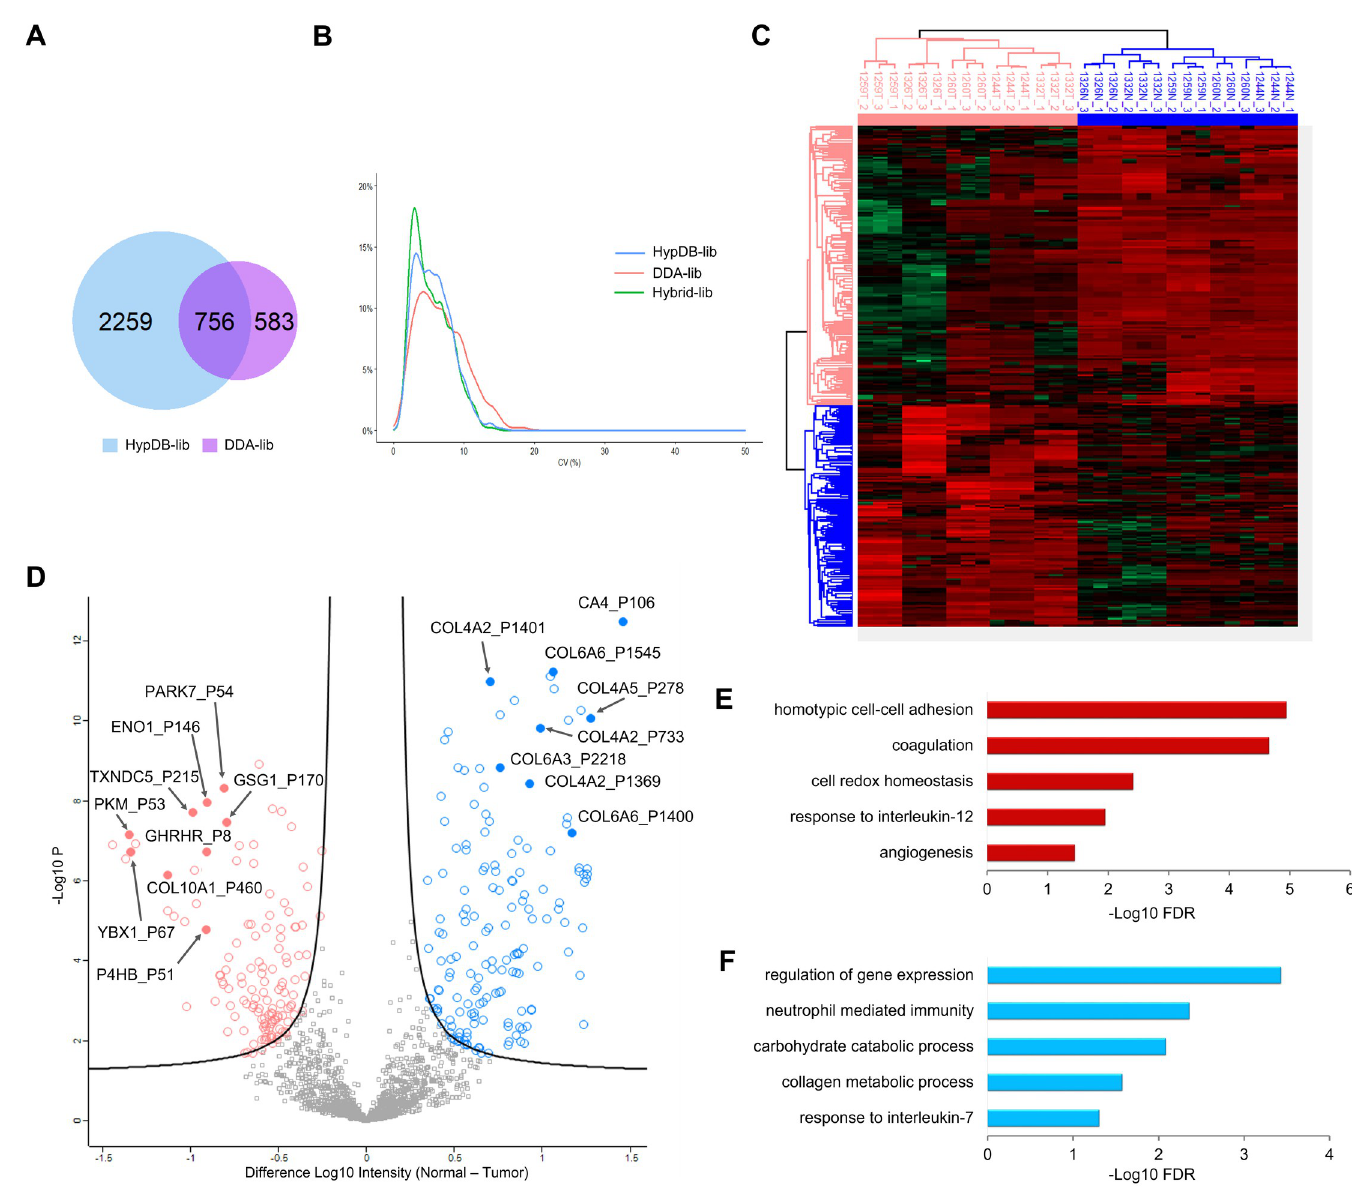
Fig 7. Label-free quantification of the Hyp proteome in lung cancer with DIA analysis. (A) Venn diagram of DIA-based Hyp site identifications using HypDB- generated library and the library generated by the DDA in Kitata and colleagues study. (B) Distribution of %CV for Hyp sites quantified with HypDB-generated library, DDA-generated library, or the hybrid library that combined both sources. (C, D) Hierarchical clustering (C) and volcano plot (D) of significantly up- or down-regulated Hyp sites in normal (blue) and tumor (red) tissues in the DIA analysis. (E, F) Significantly enriched GO biological processes among up-regulated (E) and down-regulated (F) Hyp proteins in tumor with at least 1-fold change after normalizing with protein abundance changes. Refer to Sheet A–E in S9 Table for the underlying data of Fig 7B– F. DDA, data-dependent acquisition; DIA, data-independent acquisition; Hyp, proline